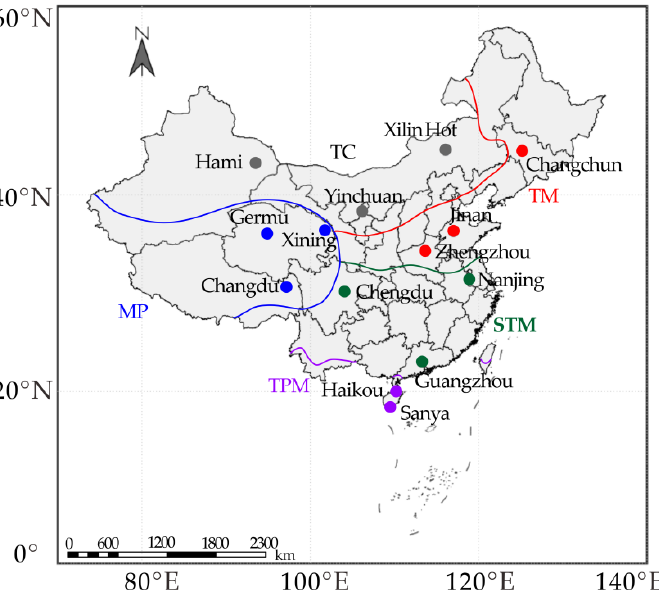
Figure 1. Geographic locations of the 14 national meteorological stations across different climatic zones of China. TC, temperate continental zone; TM, temperate monsoon zone; MP, mountain plateau zone; STM, subtropical monsoon zone; TPM, tropical monsoon zone.